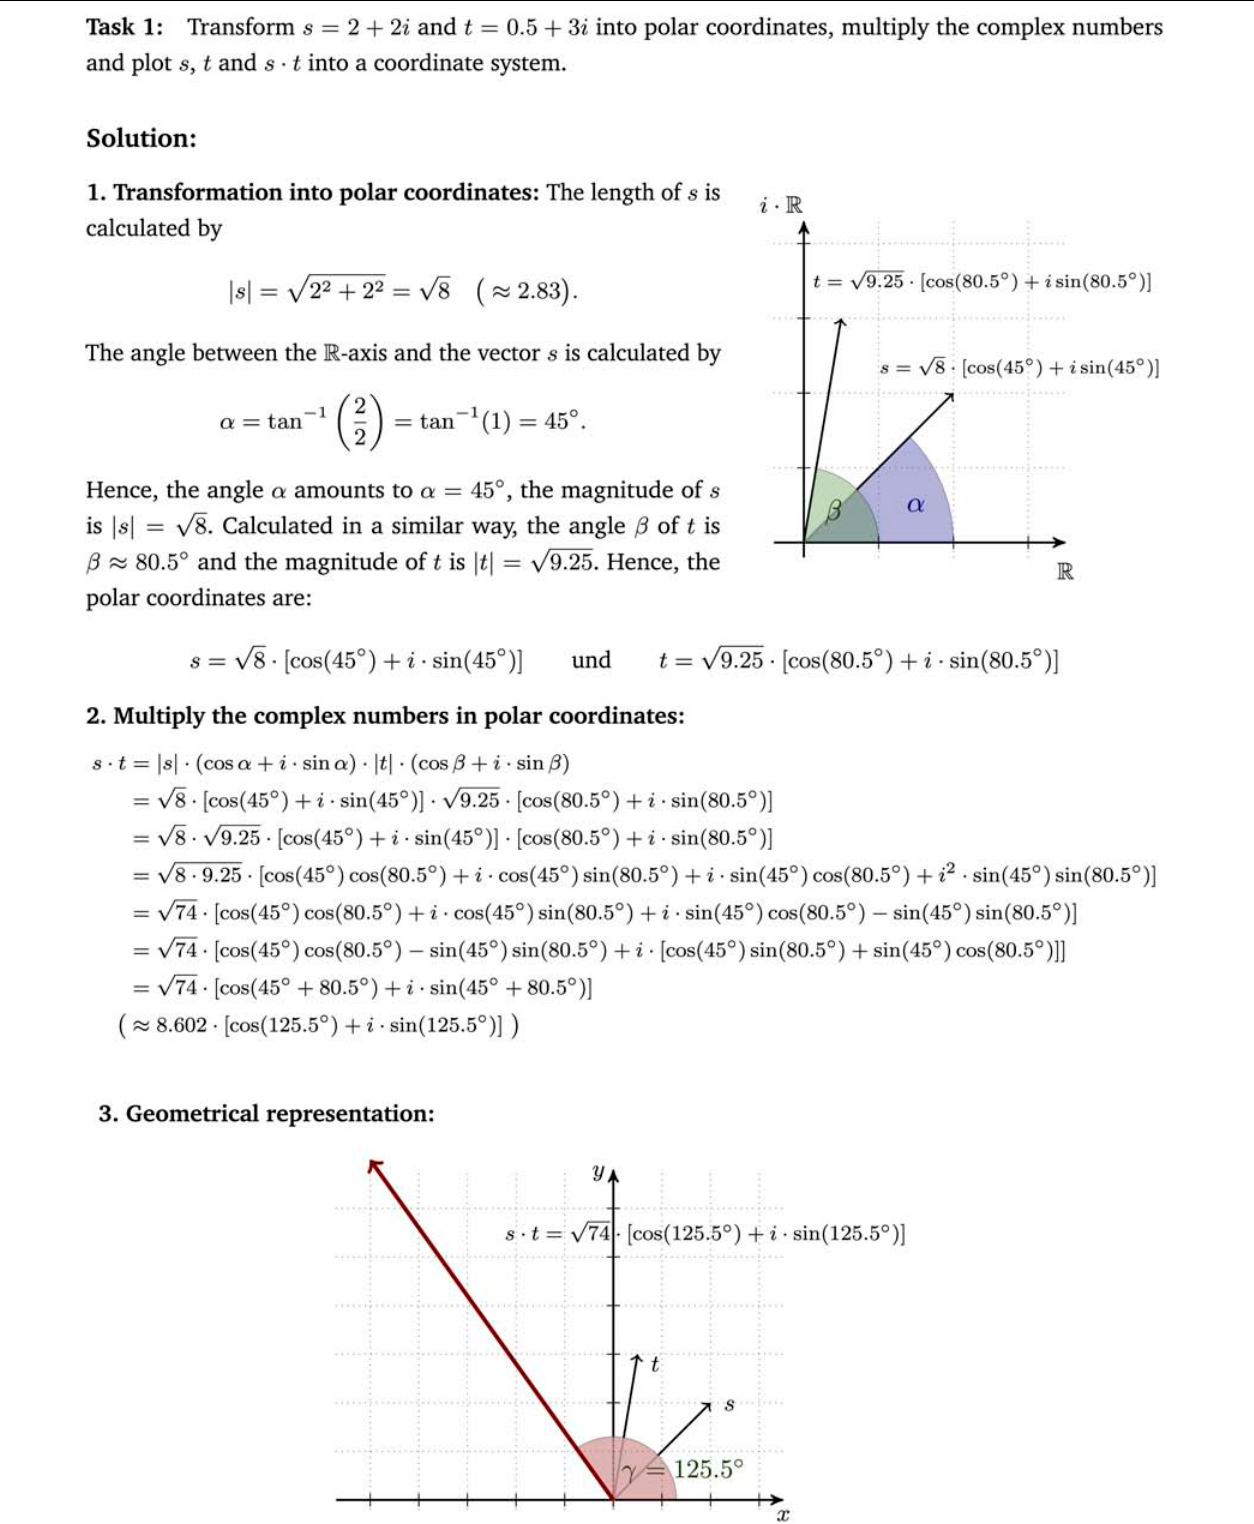
FIGURE 1 | First worked-out example that was used in the intervention phase (translated from the German original, scaled-down version).